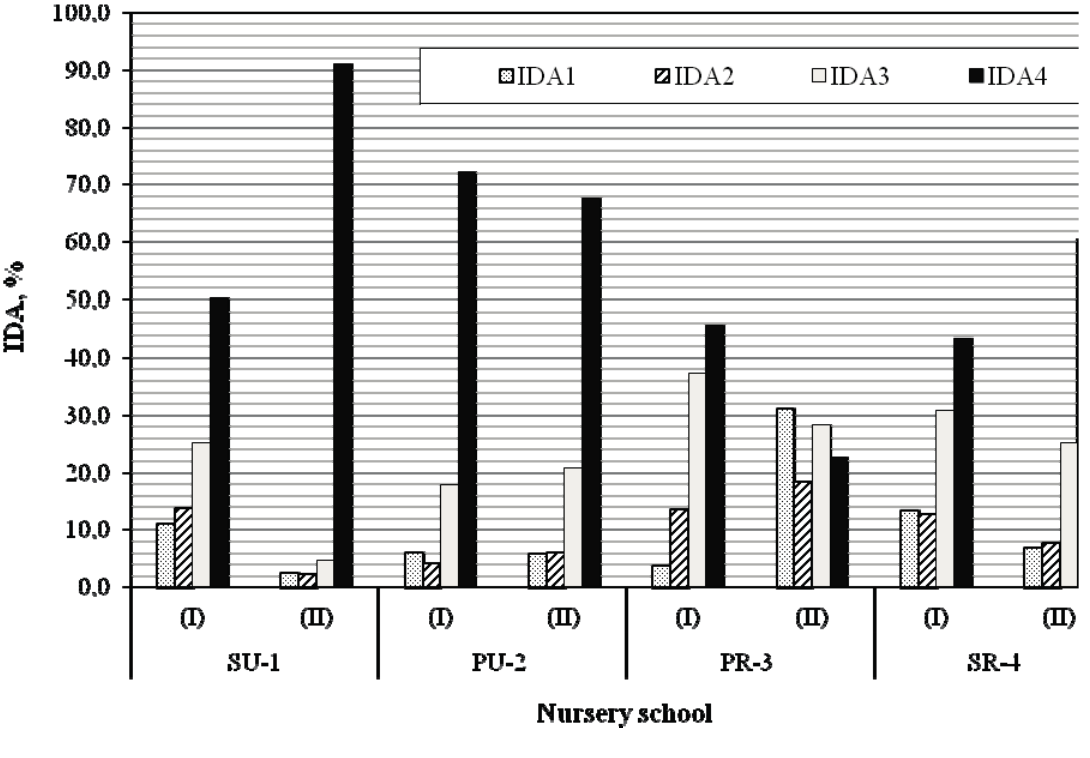
Figure 2. Classification of IAQ (IDA) in nursery school building according to growth of CO 2 concentration ( Δ CO 2